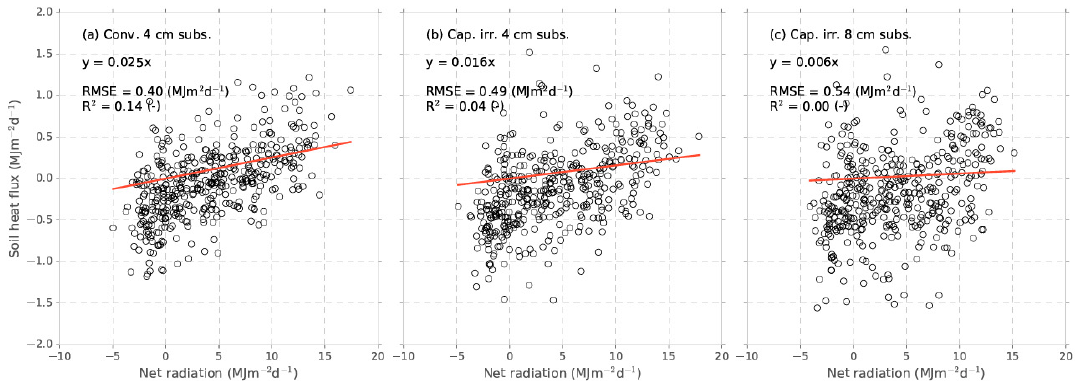
Figure A1. Linear regression between on-site measured net radiation R n and soil heat flux G.